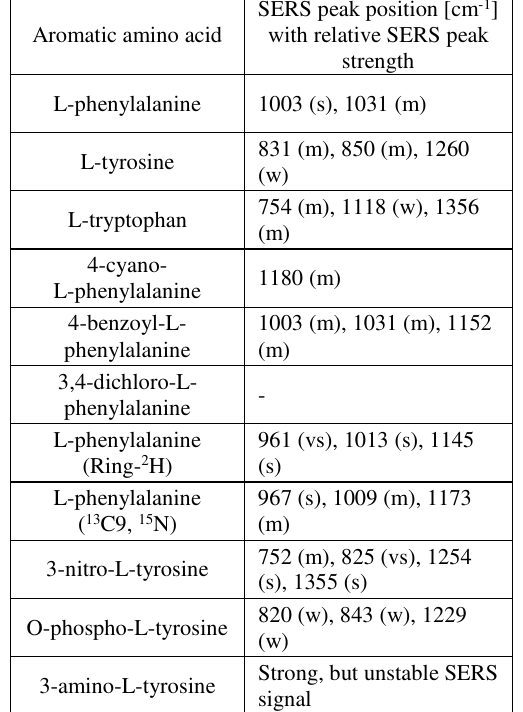
Table 1. Measured prominent SERS peak positions of different aromatic amino acids with relative SERS peak